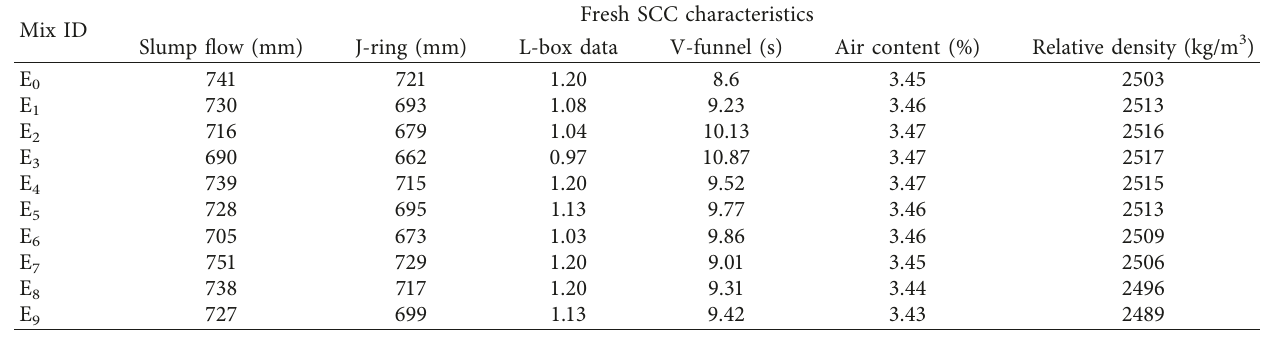
Figure 3: Laboratory testing of slump flow (a) and J-ring Table 8: Findings of SCC in its fresh state.